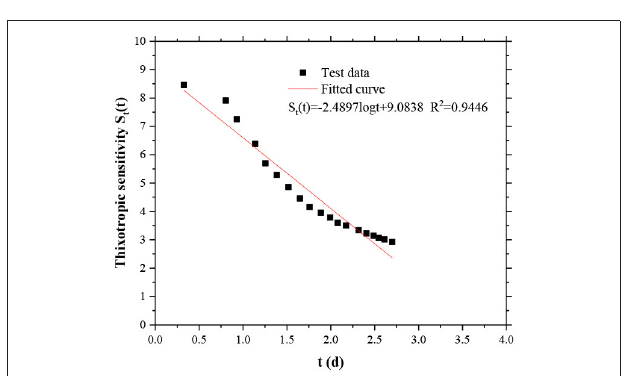
FIGURE 8 | Relationship between thixotropic sensitivity S t ( t ) and log t [modified from Zhang et al. (2014b)].